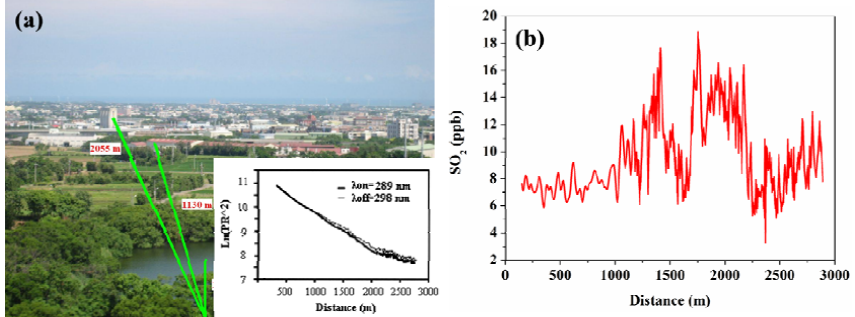
Figure 9. (a) DIAL measurement of SO 2 at NCU, Chung-Li, on 7 June 2010. The range-corrected DIAL signal measured at 289 and 298nm is shown in the inserted box. (b) The SO 2 concentration as a function of range retrieved from the DIAL